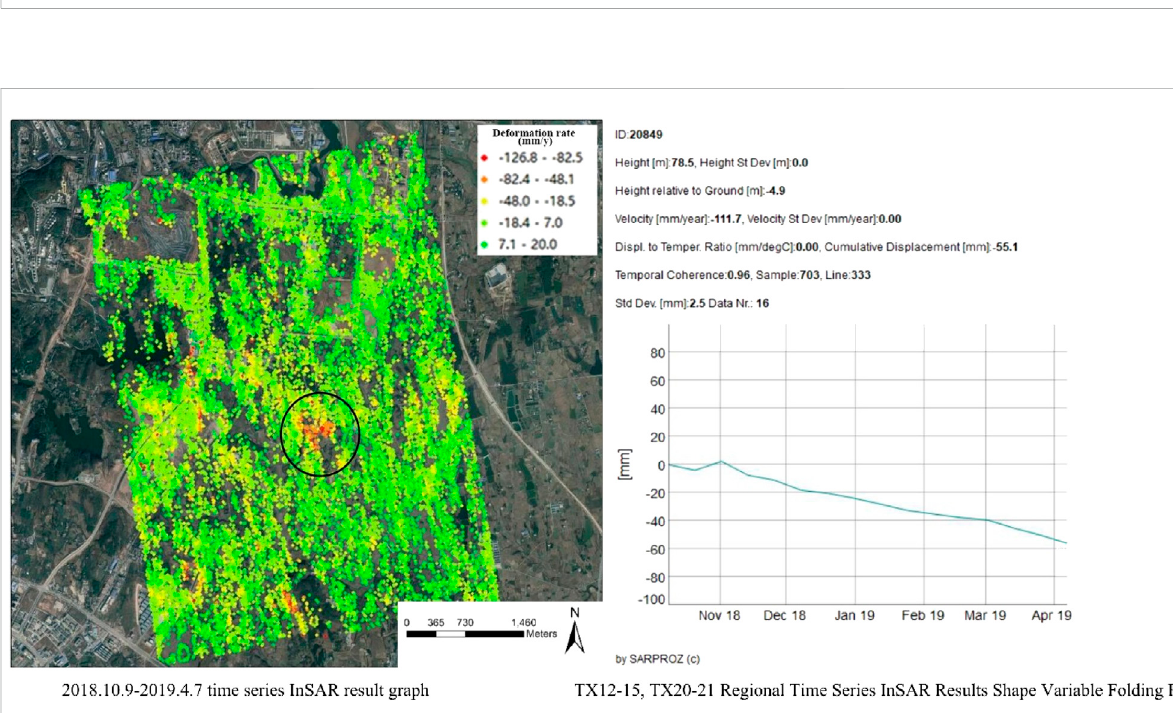
FIGURE 13 TX12-15, TX20-21 regional time series InSAR results and line graphs of shape